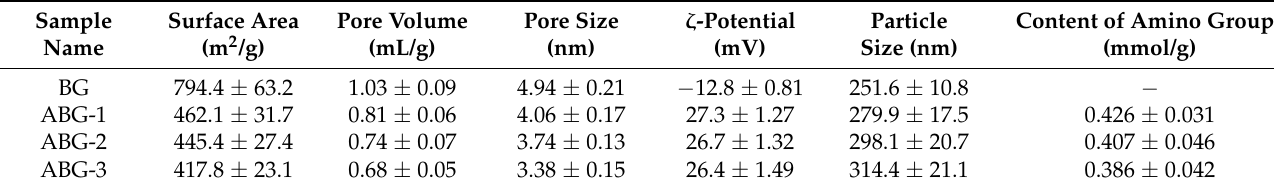
Table 1. Parameters for different kinds of